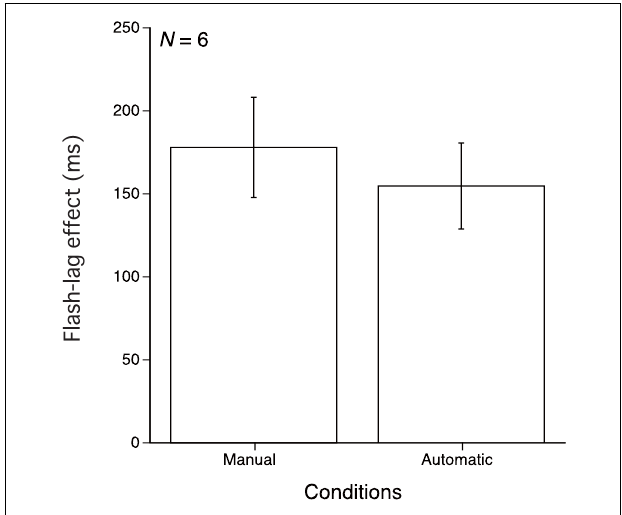
FIGURE 5 | Results of Experiment 4. Mean and SE of the 50% threshold for the two conditions.